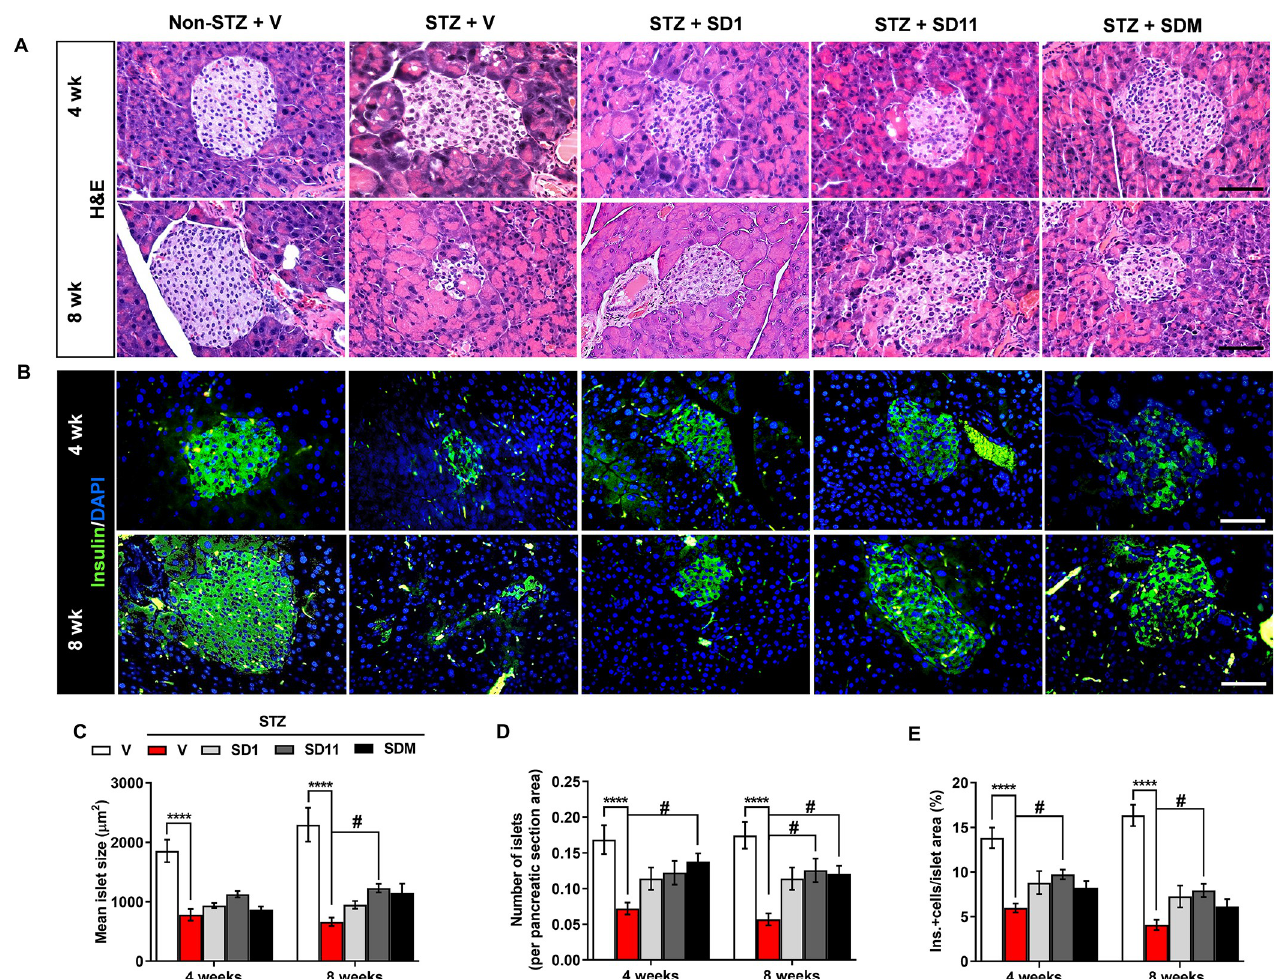
Fig 2. Probiotics attenuate STZ-induced histopathological changes in the pancreases of mice. Representative images of the pancreatic tissues from different groups were examined using (A) H&E staining and (B) β -cell marker insulin (green) and DAPI (blue) staining at the 4- and 8-week time points. (C) Distribution of islet sizes among experimental groups. (D) The average number of islets per cross-sectional area of all islets found in each group. (E) Percentage of insulin-positive cells per islet area. All images were taken at 400 magnifications. Scale bars, 50 μ m. Values represent means ± SEM. Data were obtained from 36 histological stained sections per 6 mice per group for H&E. A measurement of 50 independent islets per group (10 islets per mouse pancreas were randomly chosen from 5 animals per group) were examined for immunofluorescent staining. **** P < 0.0001 vs. the corresponding non-STZ group; # P < 0.05 vs. the corresponding vehicle-treated STZ